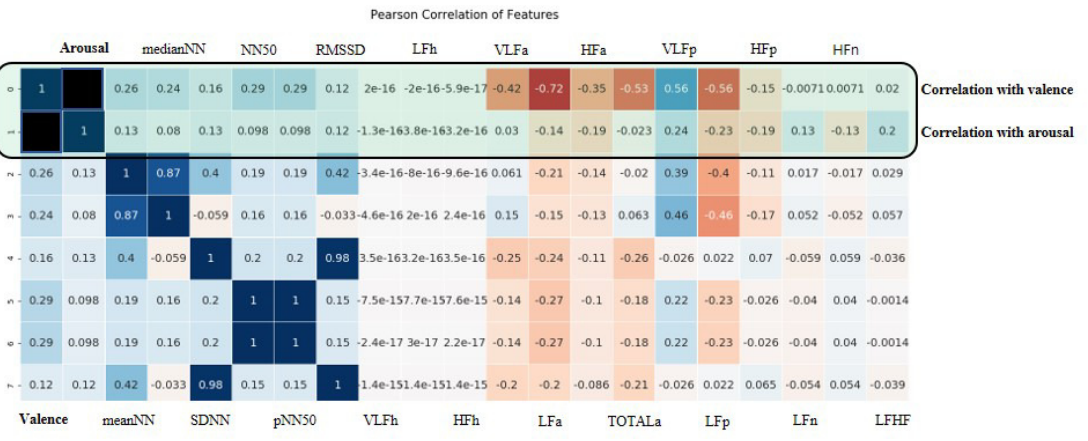
Figure 7. Pearson’s correlation result between emotion and features.